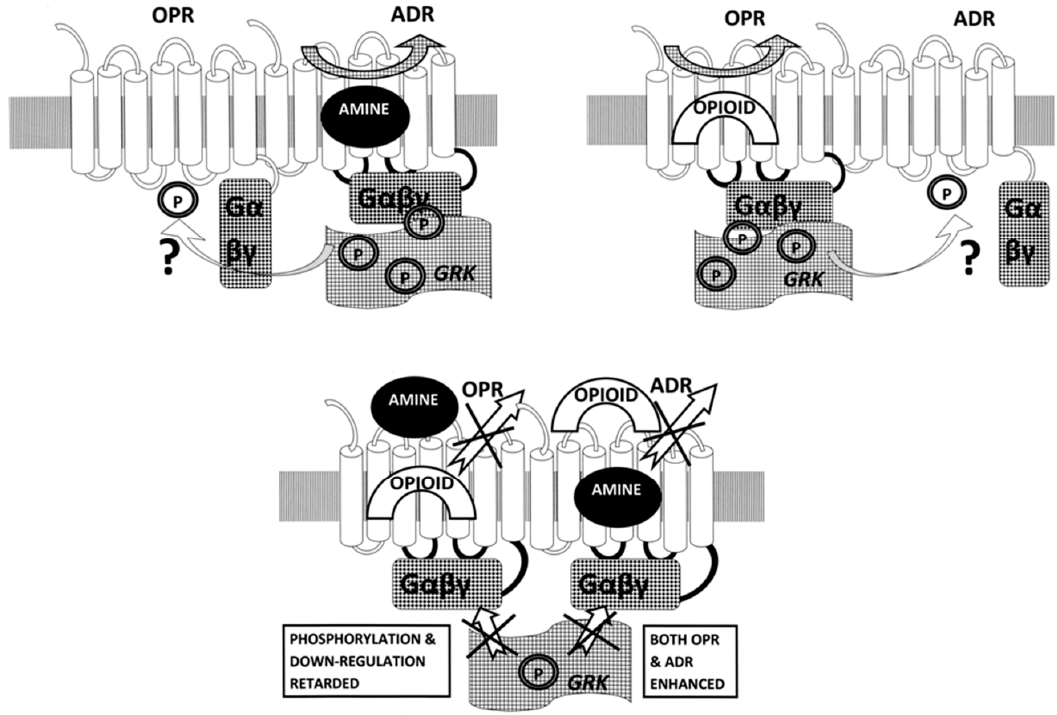
Figure 23. Schematic representation of opioid receptor (OPR) function when dimerized with adrenergic receptor (ADR). Left: In the presence of an adrenergic agonist, only the ADR is activated and the processes of G-protein recruitment (G αβγ ), kinase-mediated (GRK) phosphorylation (P), inactivation of the receptor and its internalization followed as described in [43] and for the OPR in Figure 22. One possible modification of the scheme described for individual receptors is that dimerization may result, through allosteric cross-talk, in inactivation by phosphorylation of the non-activated member of the pair as well. Right : The same process just described for ADR activation, phosphorylation and inactivation will characterize OPR activation in the heterodimer state. Below: Co-activation of both the ADR and OPR in their heterodimerized state will have very different effects than activation of each receptor independently. Both receptors will be enhanced (the ADR by opioids and the OPR by adrenergics), preventing release of the ligand, maintaining signaling and inhibiting (indicated by Xs in the figure) phosphorylation and internalization of both receptors. Allosteric cross-talk may further enhance the continued activation of the receptor pair in the dimerized state. This model explains clinical and experimental observations of adrenergic-opioid synergy and prolongation of activity, as well as inhibition of receptor phosphorylation when both compounds are